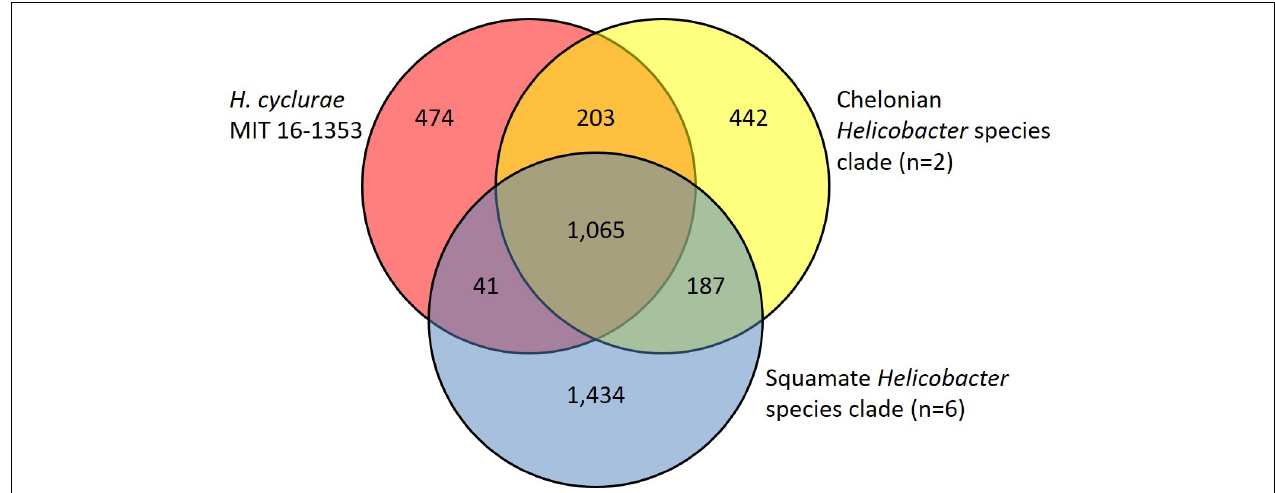
FIGURE 3 | Venn diagram showing shared and unique orthogroups among genomes from Helicobacter species isolated from reptilian hosts.